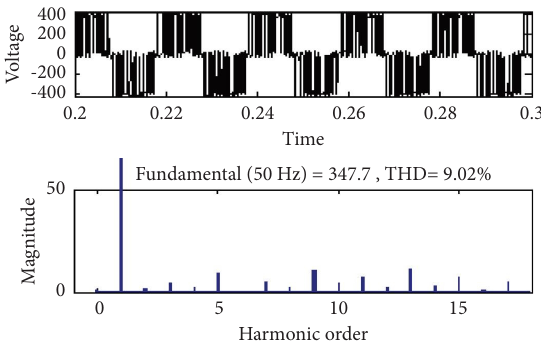
Figure 10: PSO method THD analysis of output voltage.